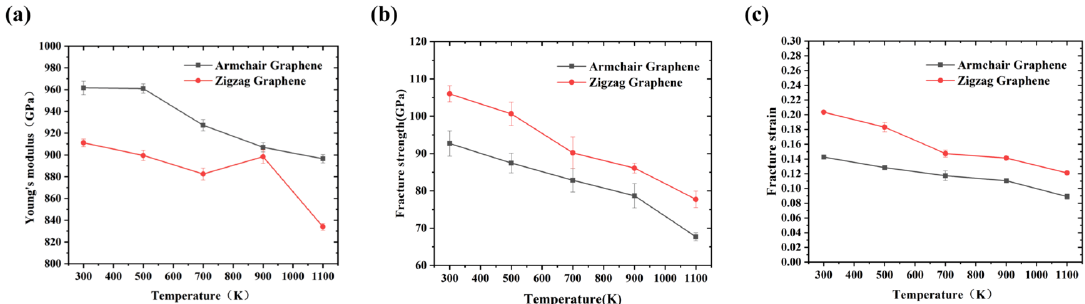
Figure 7. ( a ) The Young’s modulus; ( b ) the fracture strength; and ( c ) the fracture strain of Gr along the armchair and zigzag directions at different temperatures.